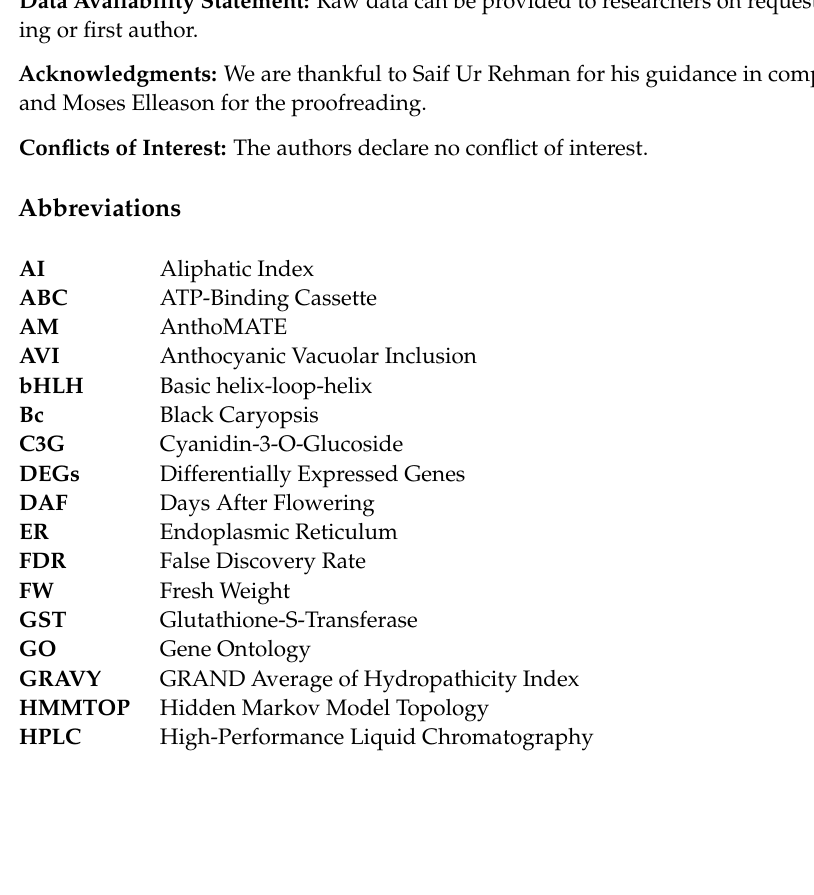
Table S4: Similarity index and identity; Table S5: The basic information about MATE protein lo- calization; Table S6: Expression pattern of anthocyanin biosynthesis and transporter genes based on fold-change levels in Bc and Wc; Figure S1: Anthocyanin quantification in black rice caryopsis at different developmental stages; Figure S2: Secondary structures of the 6 rice MATEs proteins and 7 anthocyanin MATEs-like proteins predicted by SOPMA; Figure S3: Topological analysis of OsMATEs; Figure S4: Comparison of the three-dimensional configuration of two putative OsMATEs and six anthoMATEs. File S1: GO and KEGG pathway analysis; File S2: Differentially expressed genes of anthocyanin biosynthesis pathway analysis and function; File S3: Quality control protocol of RNA-sequencing